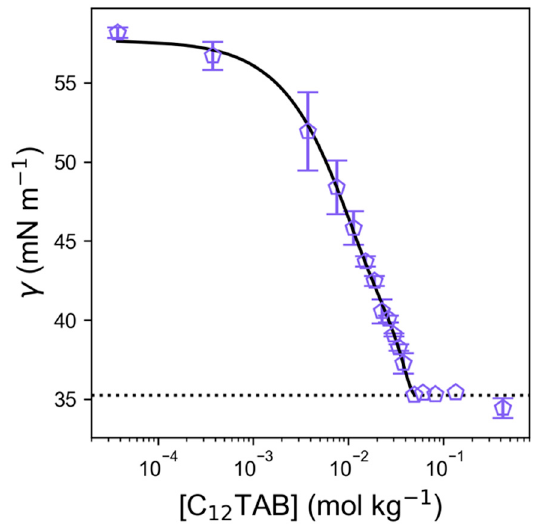
Figure 3. Surface tension plot showing measured CMC of C 12 TAB in ethaline. The solid line represents a quartic polynomial fit, which is used to obtain the maximum gradient, and hence, the fitted Gibbs adsorption isotherm and CMC values. The dashed line shows the limiting surface tension at CMC, γ CMC (35.25 mN m − 1 ).